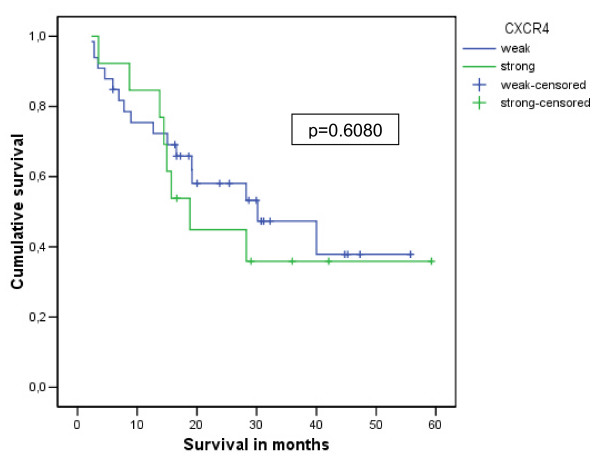
Kaplan-Meier survival curves for patients with adenocarcinoma and weak (CXCR4w) versus strong (CXCR4s) chemokine receptor expression.